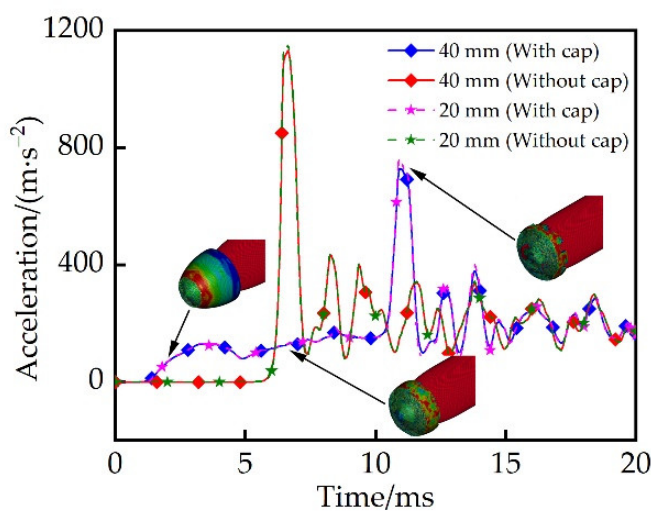
Figure 13. Acceleration of vehicle vertical water entry at 100 m/s.